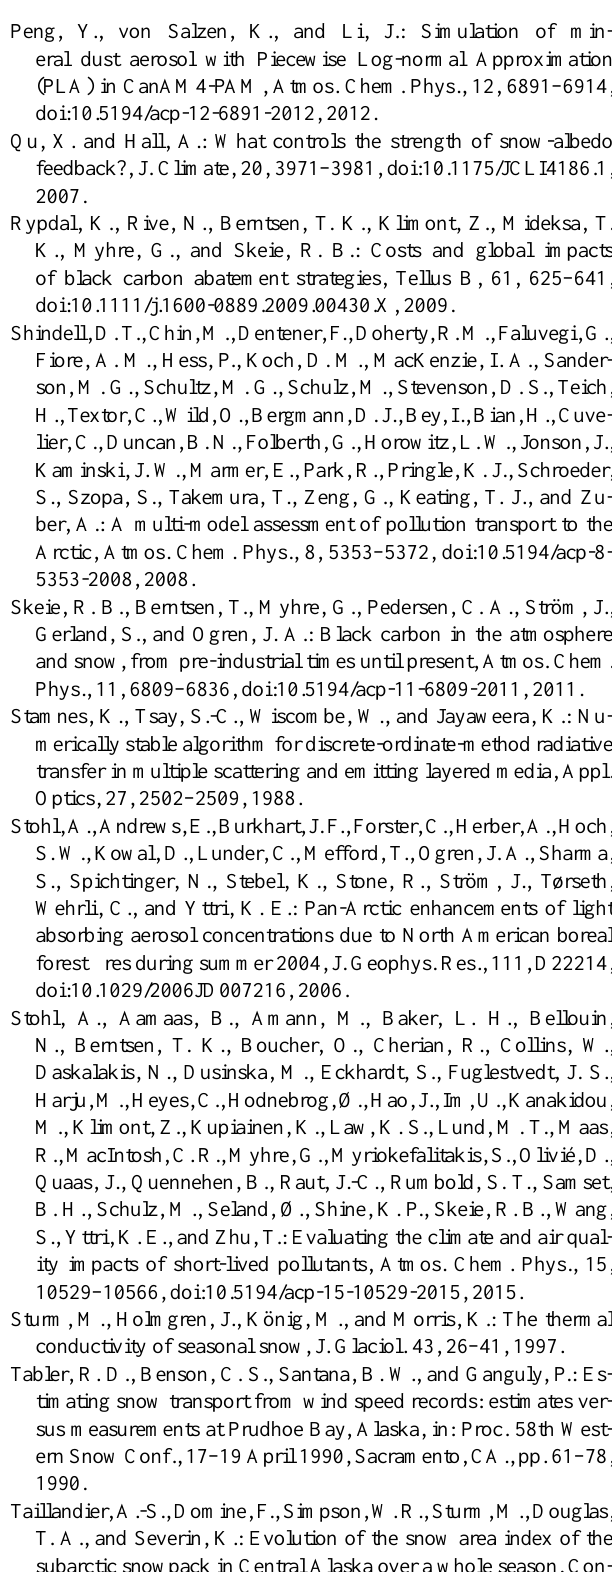
Tabler, R. D., Benson, C. S., Santana, B. W., and Ganguly, P.: Es- timating snow transport from wind speed records: estimates